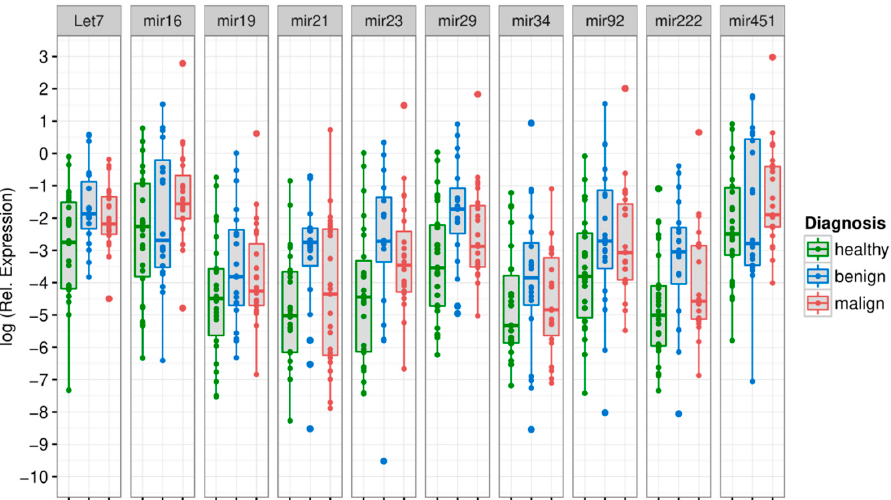
Figure 2. Boxplots of median total miRNA concentrations in the exosomal compartment, differenti- ated for different diagnoses (healthy, adenoma, carcinoma) and miRNAs. Healthy controls: green boxplot, adenoma patients: blue boxplot, carcinoma patients: red boxplot. Table 2. Median-normalized miRNA values in the exosomal compartment. Comparisons of different diagnoses (healthy controls, adenoma patients, carcinoma patients) were made. Differences are shown as p -values. p -values of <0.05 (highlighted with *) were considered to be statistically significant. miRNA Healthy vs. Adenoma Healthy vs. CRC Adenoma vs. CRC Let7 0.008 * 0.035